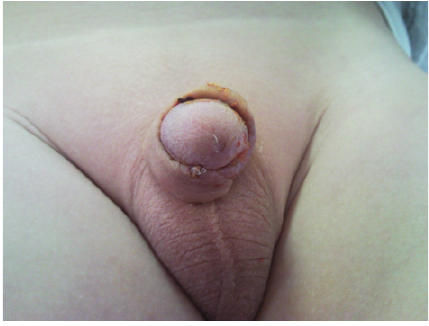
Figure 2: Same patient after recovery following medical treatment.